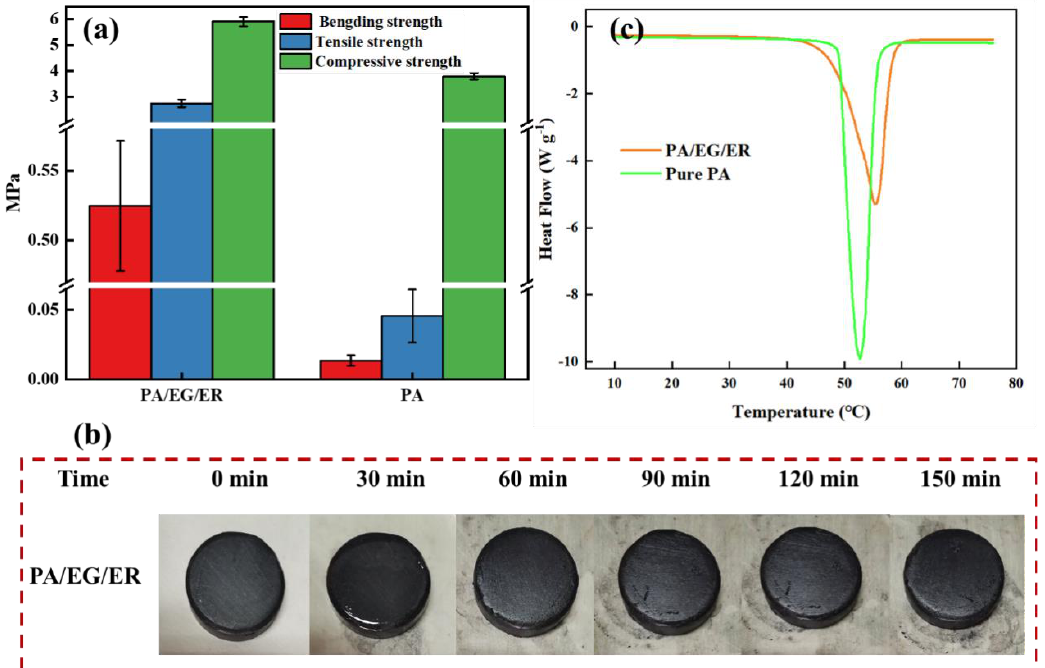
Figure 5. ( a ) Bending strength, tensile strength and compressive strength and ( b ) stability tests of the PA/EG/ER specimen; ( c ) DSC testing results of the samples.